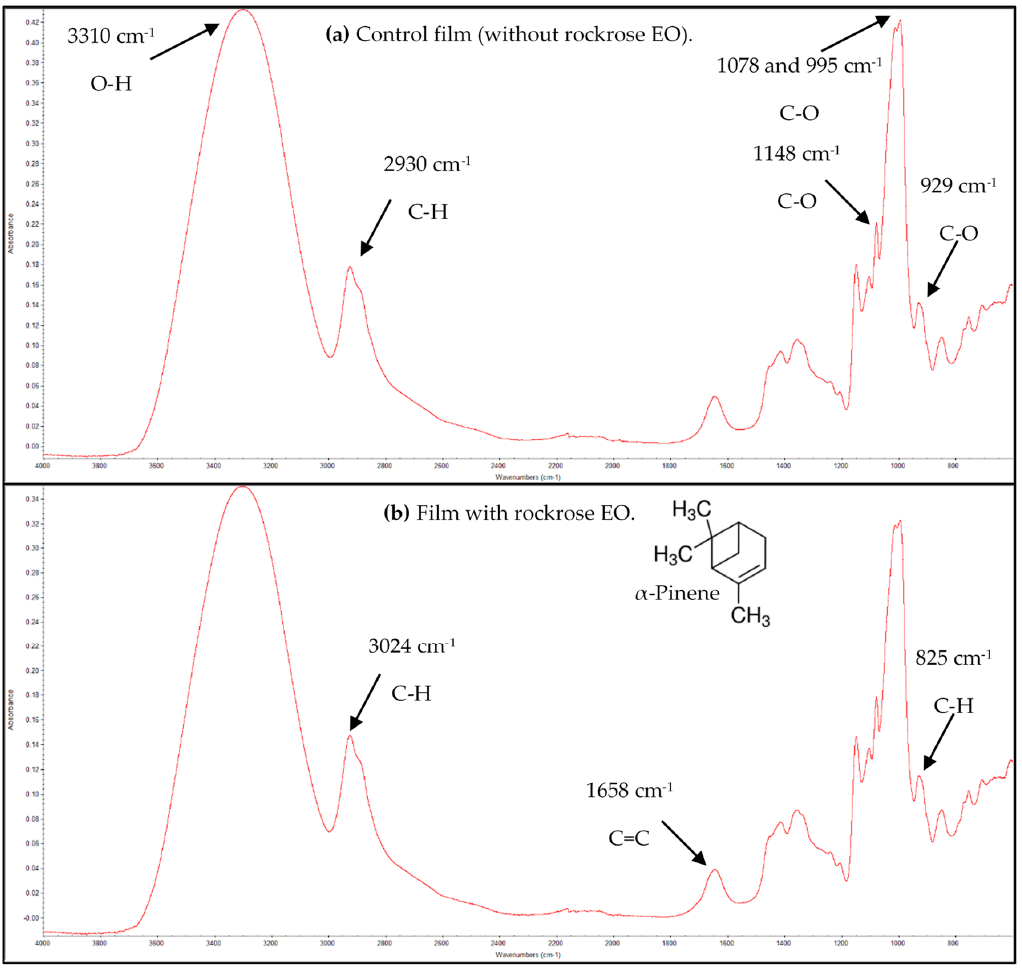
Figure 1. FTIR spectra of the pullulan-based films.